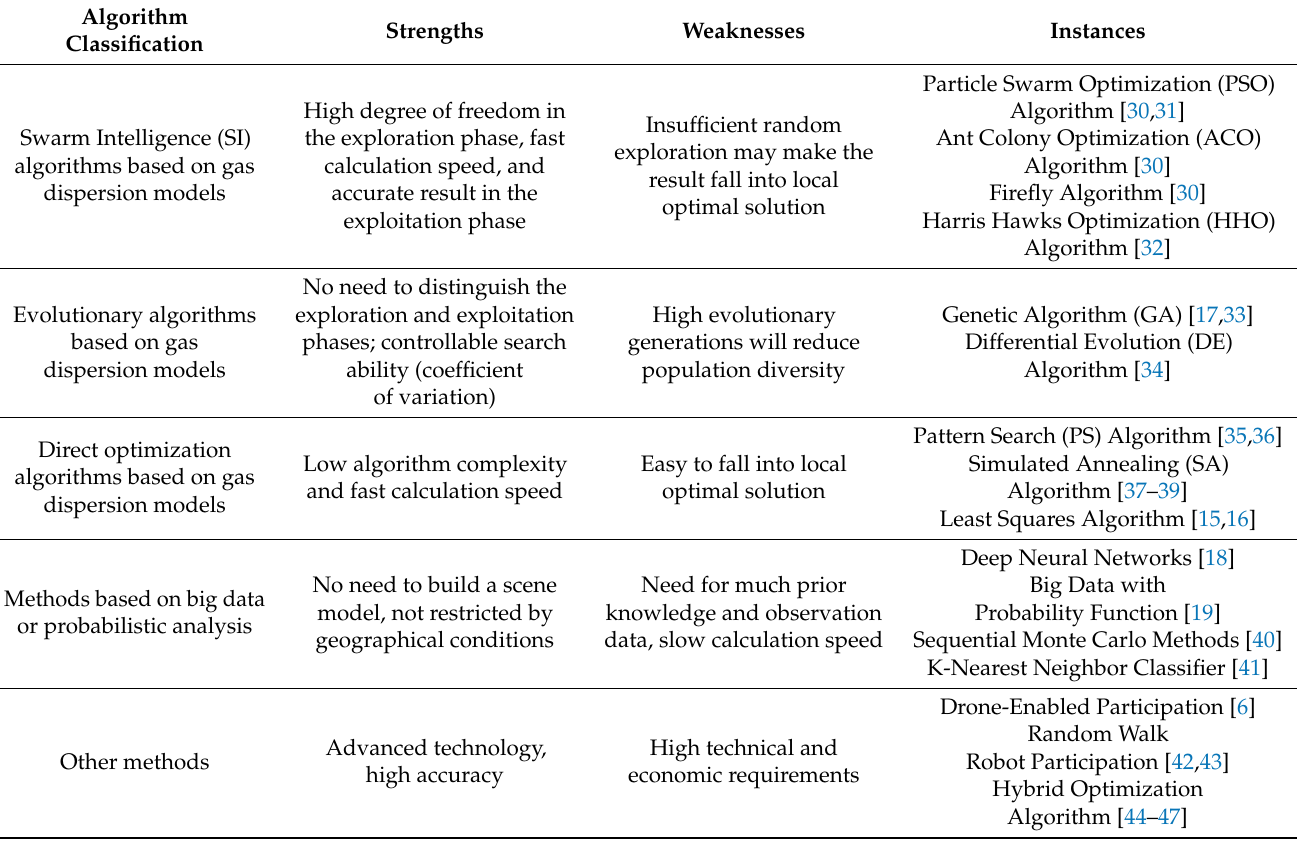
Table 2. Methods for source tracking of chemical gas